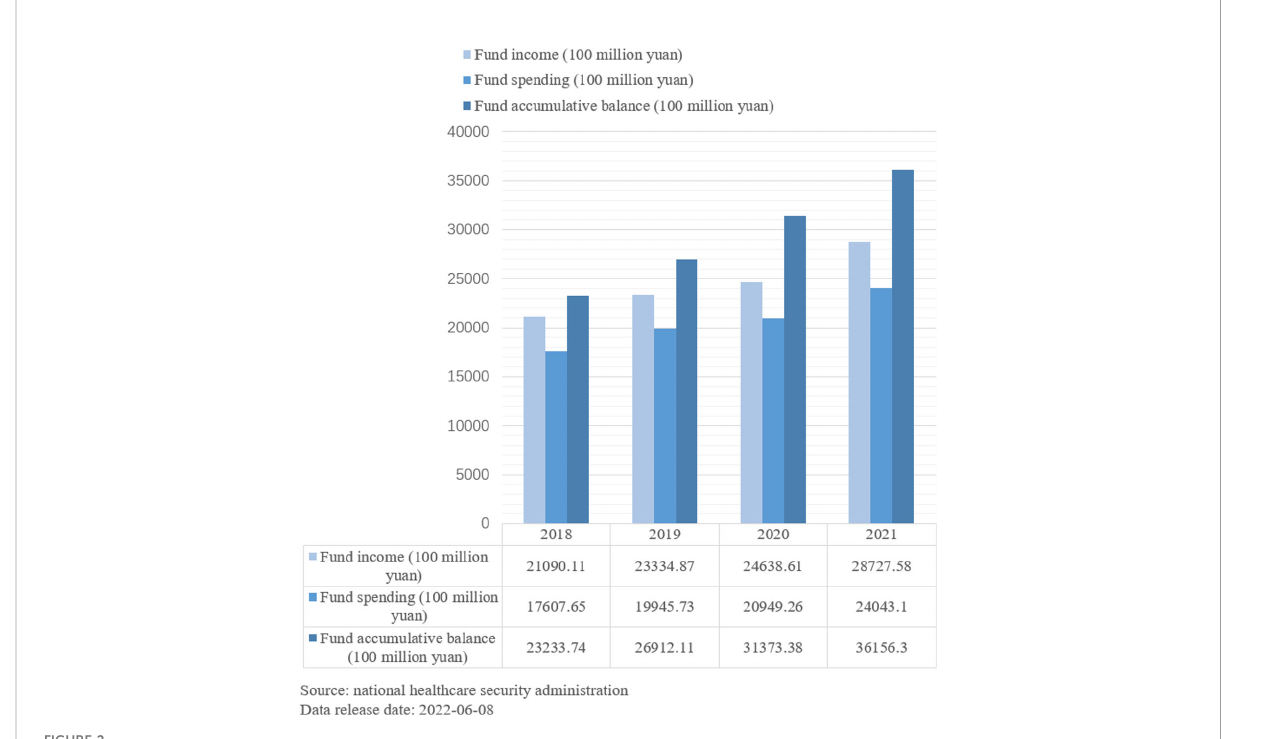
FIGURE 2 Income and expenditure of basic medical insurance fund, 2018 –